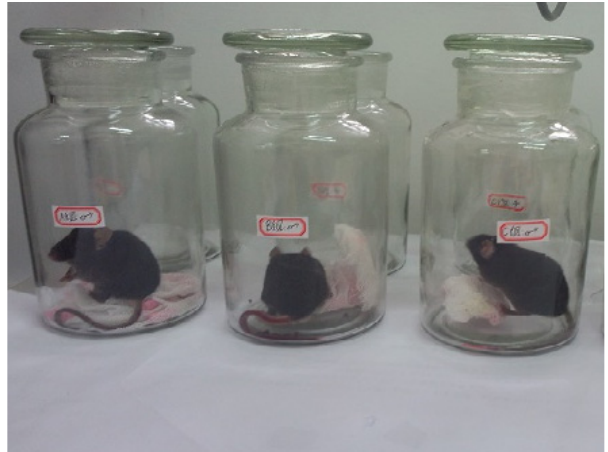
Fig. 4. Normobaric hypoxia tolerance test: All mice were put into a 250 mL wide mouth bottle ¯lled with 20 g soda lime (each bottle only 1 mice), and then quickly covered and timing starts until the mice stopped